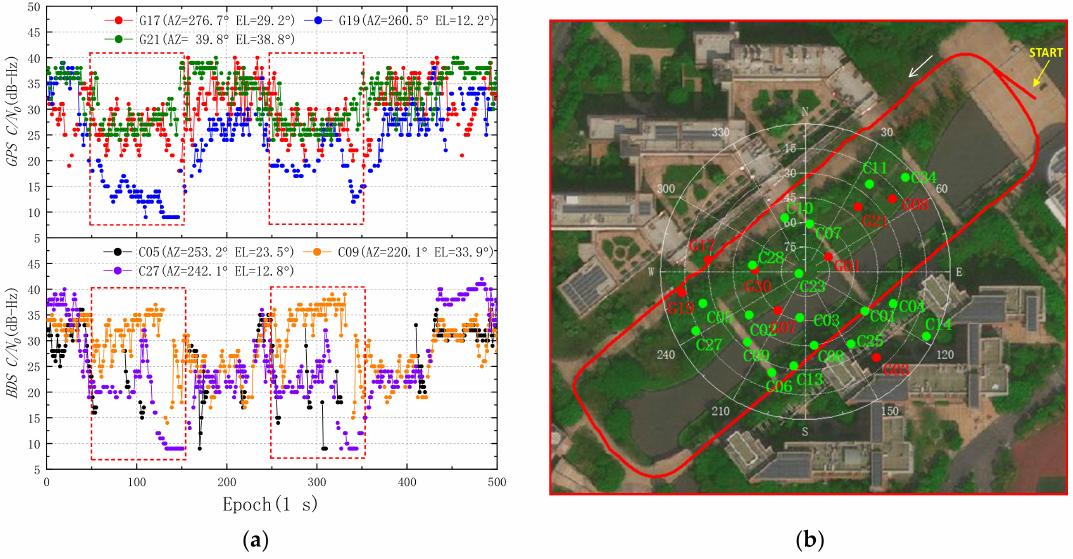
Figure 6. The C/N 0 values of GNSS satellites observed by the Huawei Mate 30 on the sidewalk in area 2. ( a ) The same GPS and BDS satellites as in Figure 4a, and the red box shows the C/N 0 values of the satellites decrease significantly. ( b ) Reference trajectory and sky plot of GPS and